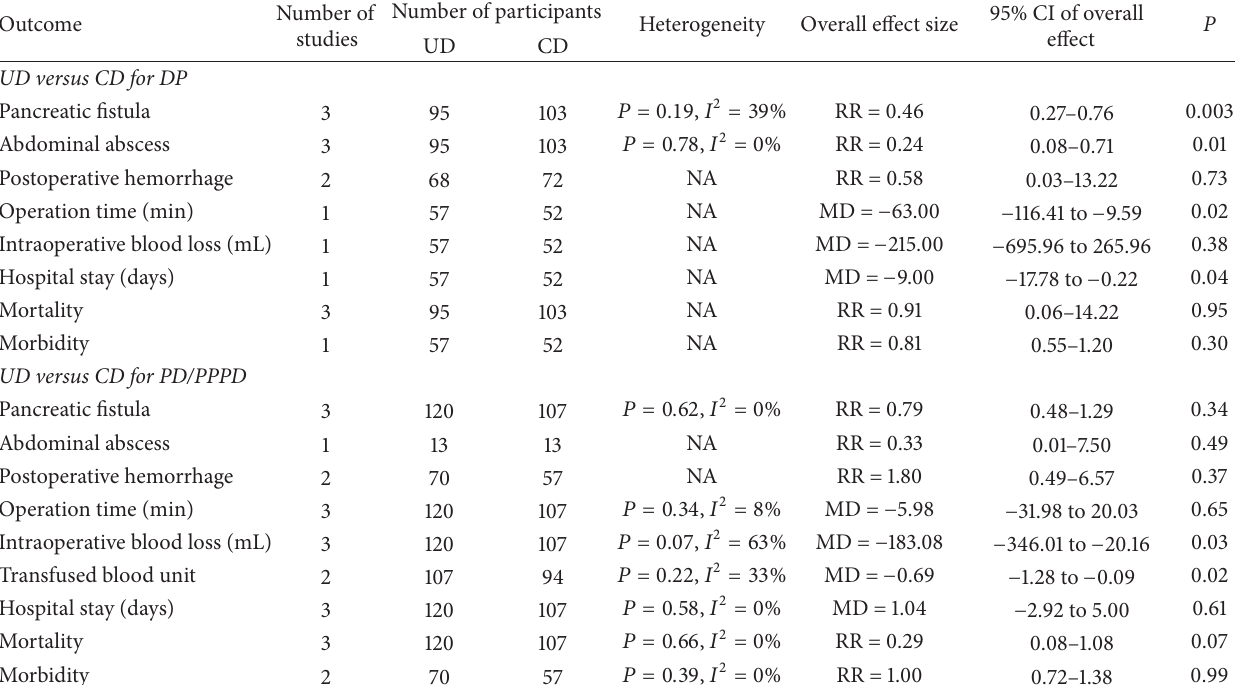
Table 2: Summary of